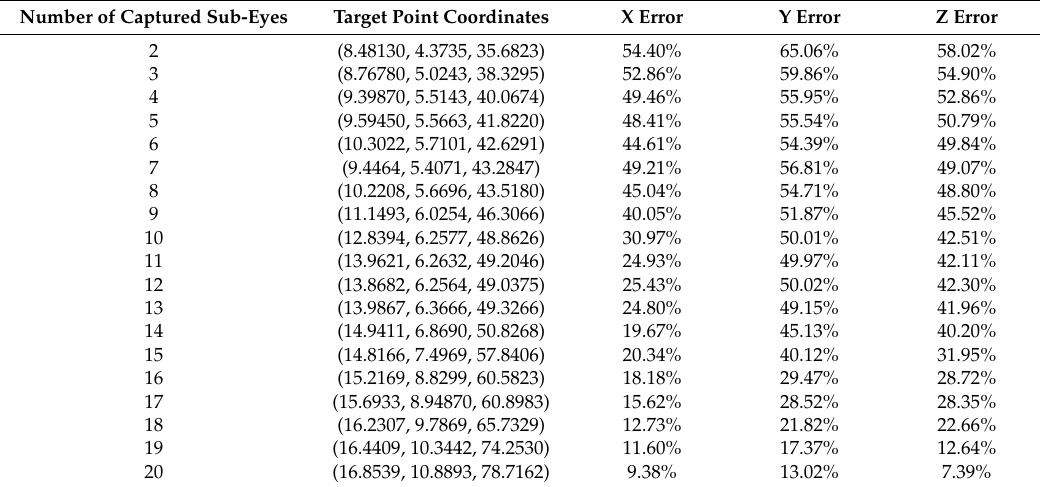
Table 6. Calculated target point coordinate values and errors.